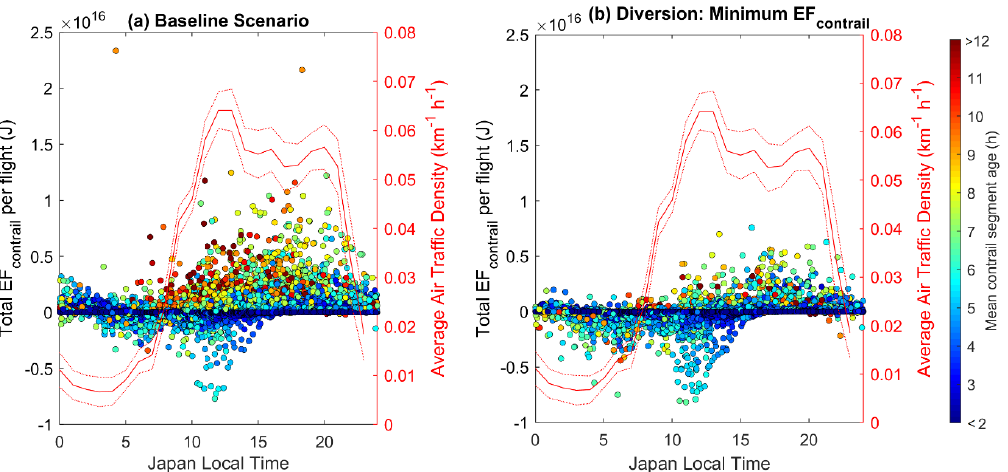
Figure 2. The EF contrail for each flight vs. the time of day when these flights occur from one run of Monte Carlo simulation, where ( a ) is the baseline scenario; and ( b ) is the strategy with flight trajectories changed to achieve a minimum EF contrail . All contrail-forming flights in the CARATS Open Data are included, and the mean contrail segment age is shown by the symbol colour. The red lines refer to the right-axis, showing the air traffic density > 20,000 feet (mean ± 1.96σ) vs. the time of the day.